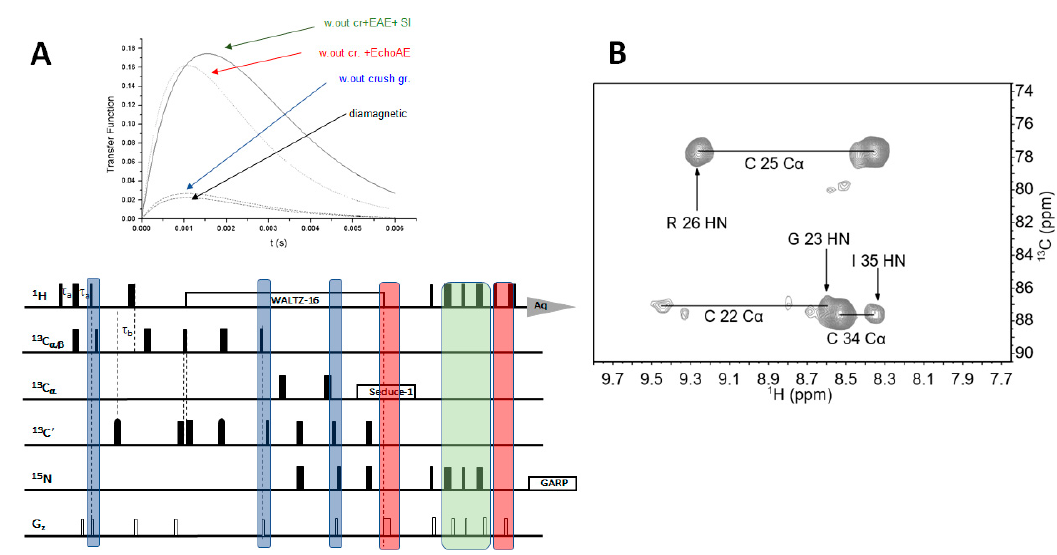
Figure 3. ( A ) Lower part: pulse scheme for a routine CBCA(CO)NH experiment [87]. Blocks highlighted in blue are the crush gradients that can be removed without affecting the coherence transfer pathways of the sequence, those in red correspond to the echo-antiecho blocks, and the one in green refers to the sensitivity improvement part of the reverse INEPT. Upper part: Calculated transfer functions for the NH reverse INEPT transfer for a 1 H signal with R 2 = 600 s − 1 , R 1 = 120 s − 1 , considering τ e = 5 × 10 − 10 s and τ = 6 × 10 − 9 s [85]. All transfer functions are normalized with respect to a normal reverse INEPT under r optimized condition for the transfer delay and neglecting losses due to 1 H- 15 N relaxation. ( B ) 500 MHz 298 K, H(N)CA spectrum of HiPIP protein PioC optimized for peaks involving fast relaxing resonances. The experiment allows identification and assignment of three out of the four cluster-bound cysteines in the HNCA. Adapted from Reference